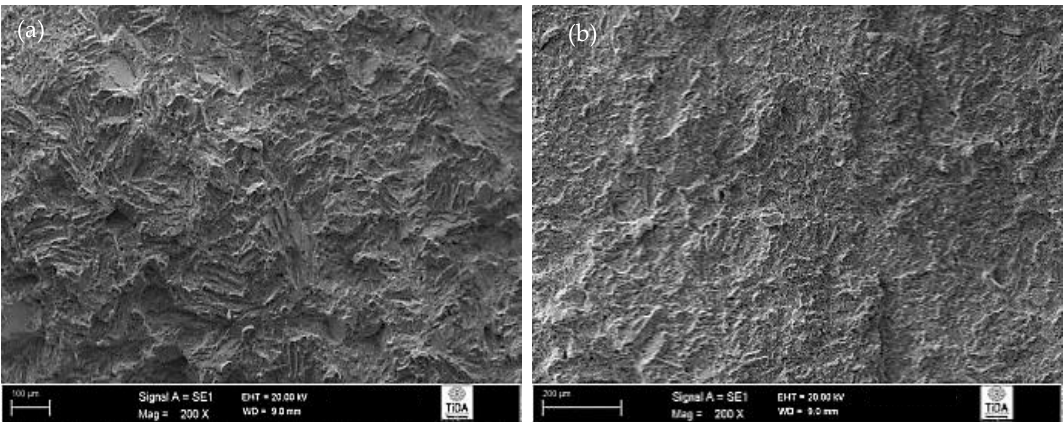
Figure 13. Typical fractographs of as-extruded Charpy impact specimens: ( a ) cleavage and Figure13. Typicalfractographsofas-extrudedCharpyimpactspecimens: ( a )cleavageandtransgranular transgranular fracture; ( b ) relatively flat surface with brittle fracture. fracture; ( b ) relatively flat surface with brittle